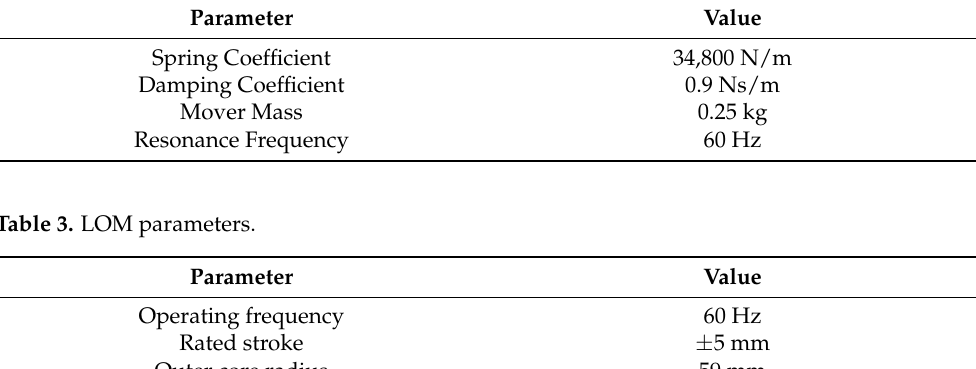
Figure 11. Analysis model including mechanical system of LOA. Table 2. Parameters for dynamic analysis of LOM. Table 2. Parameters for dynamic analysis of LOM.